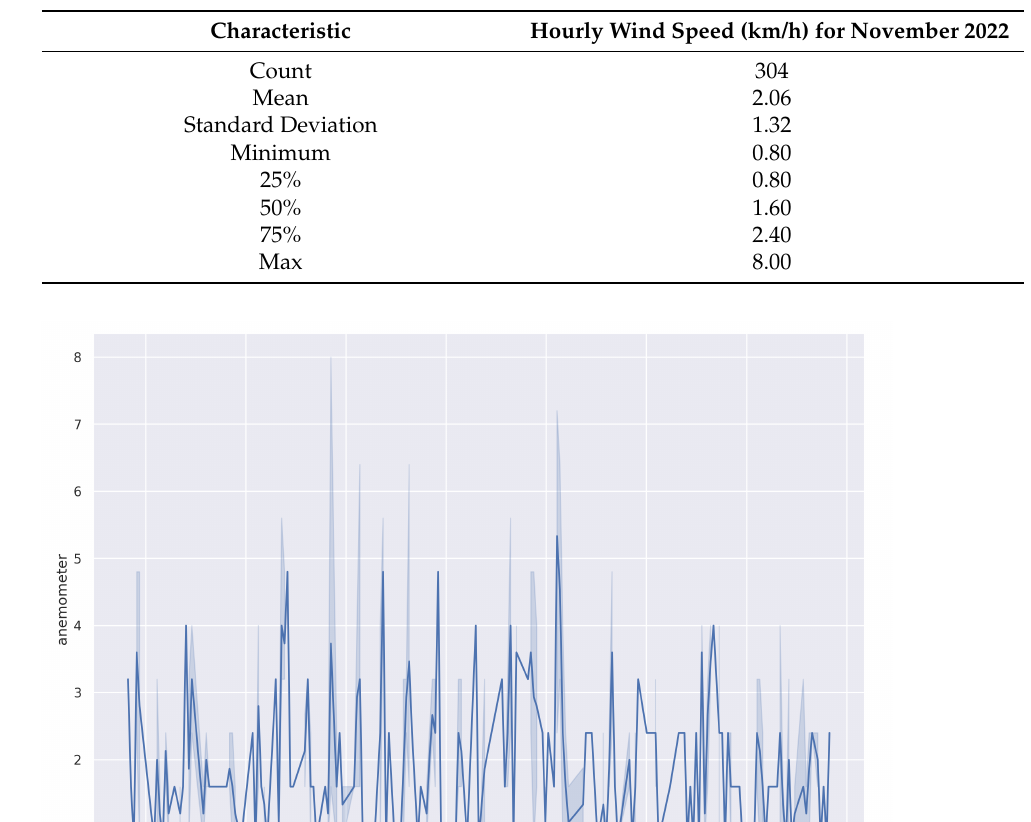
Table 6. Characteristics of wind-speed data from one location.